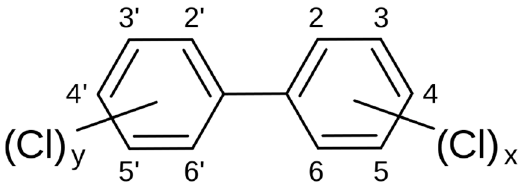
Figure 1. Molecular structure of polychlorinated biphenyls (PCBs) showing the 10 potential positions for chlorine to bind to.